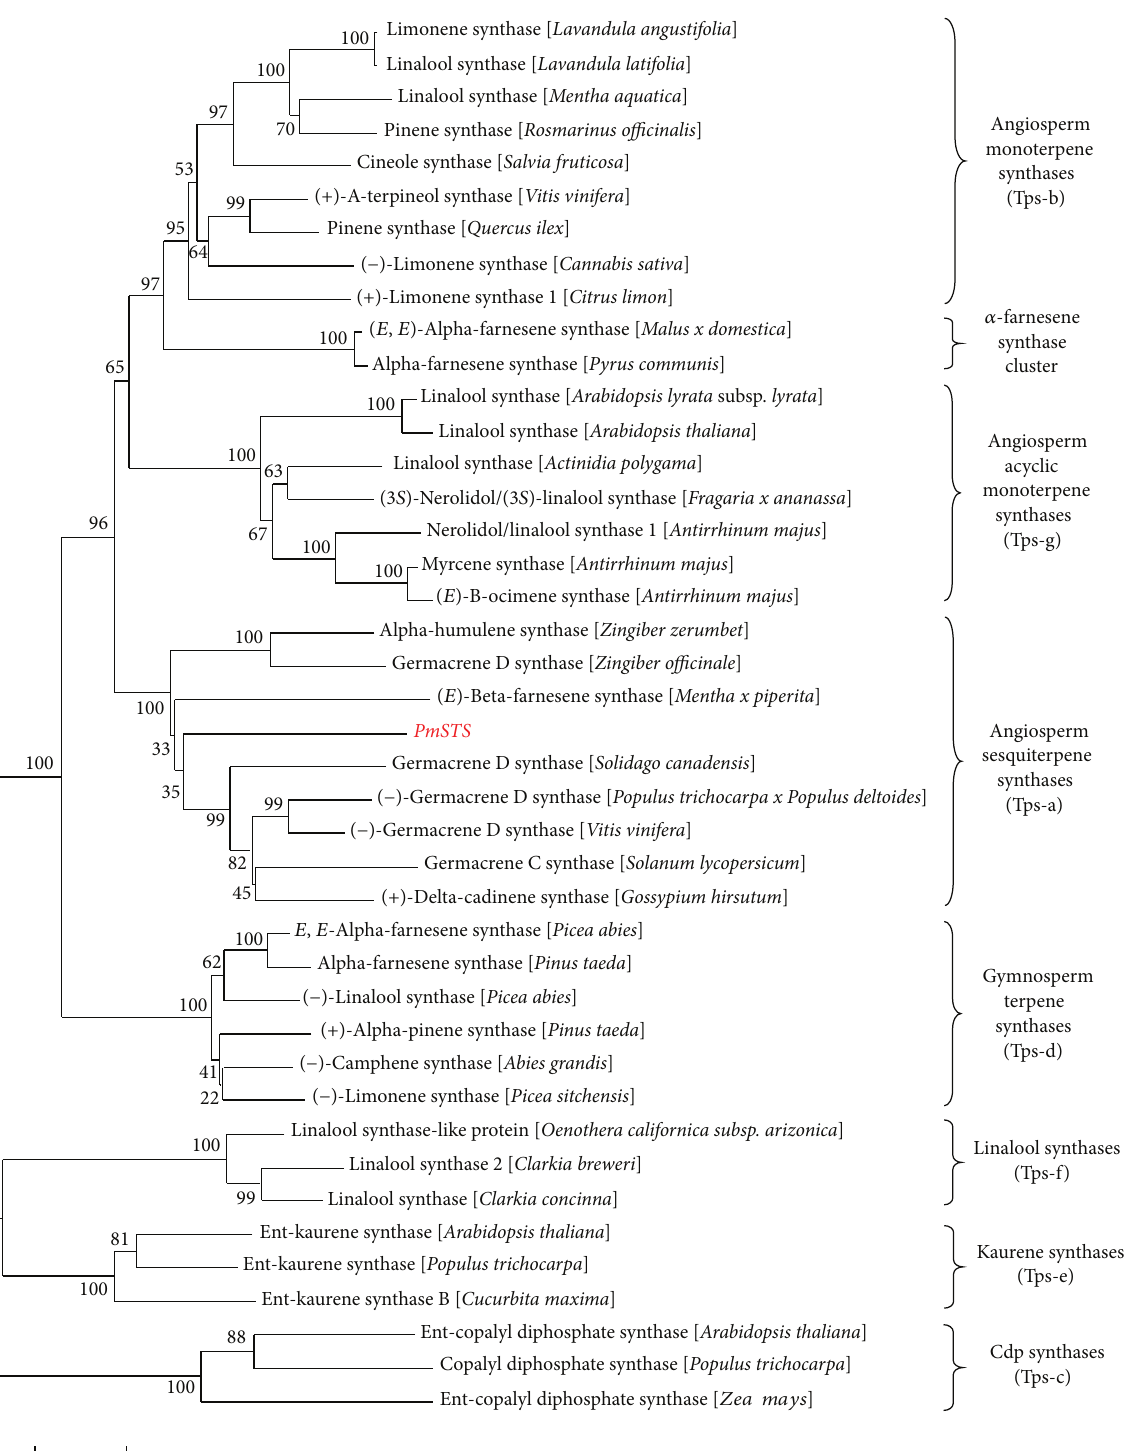
Figure4:PhylogenetictreeofPmSTSwithselectedterpenesynthasesfromotherplants.SevenpreviouslyidentifiedTPSsubfamilies(Tps-ato Tps-g) were chosen based on Bohlmann et al. [15] and Danner et al. [16]. The Tps-c and Tps-e subfamilies, which are composed of the copalyl diphosphate (cdp) synthases and kaurene synthases and are involved in primary metabolism, were chosen as outgroups. The alignment was performed using the Clustal Omega algorithm. The tree was built using the neighbour joining method and 1000 replicates for bootstrapping. The numbers indicated are the actual bootstrap values of the